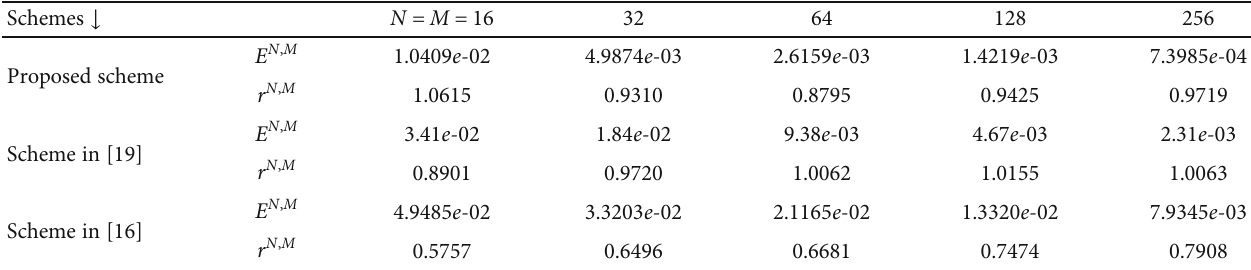
Table 4: Comparison of uniform error and uniform rate of convergence of Example 19.